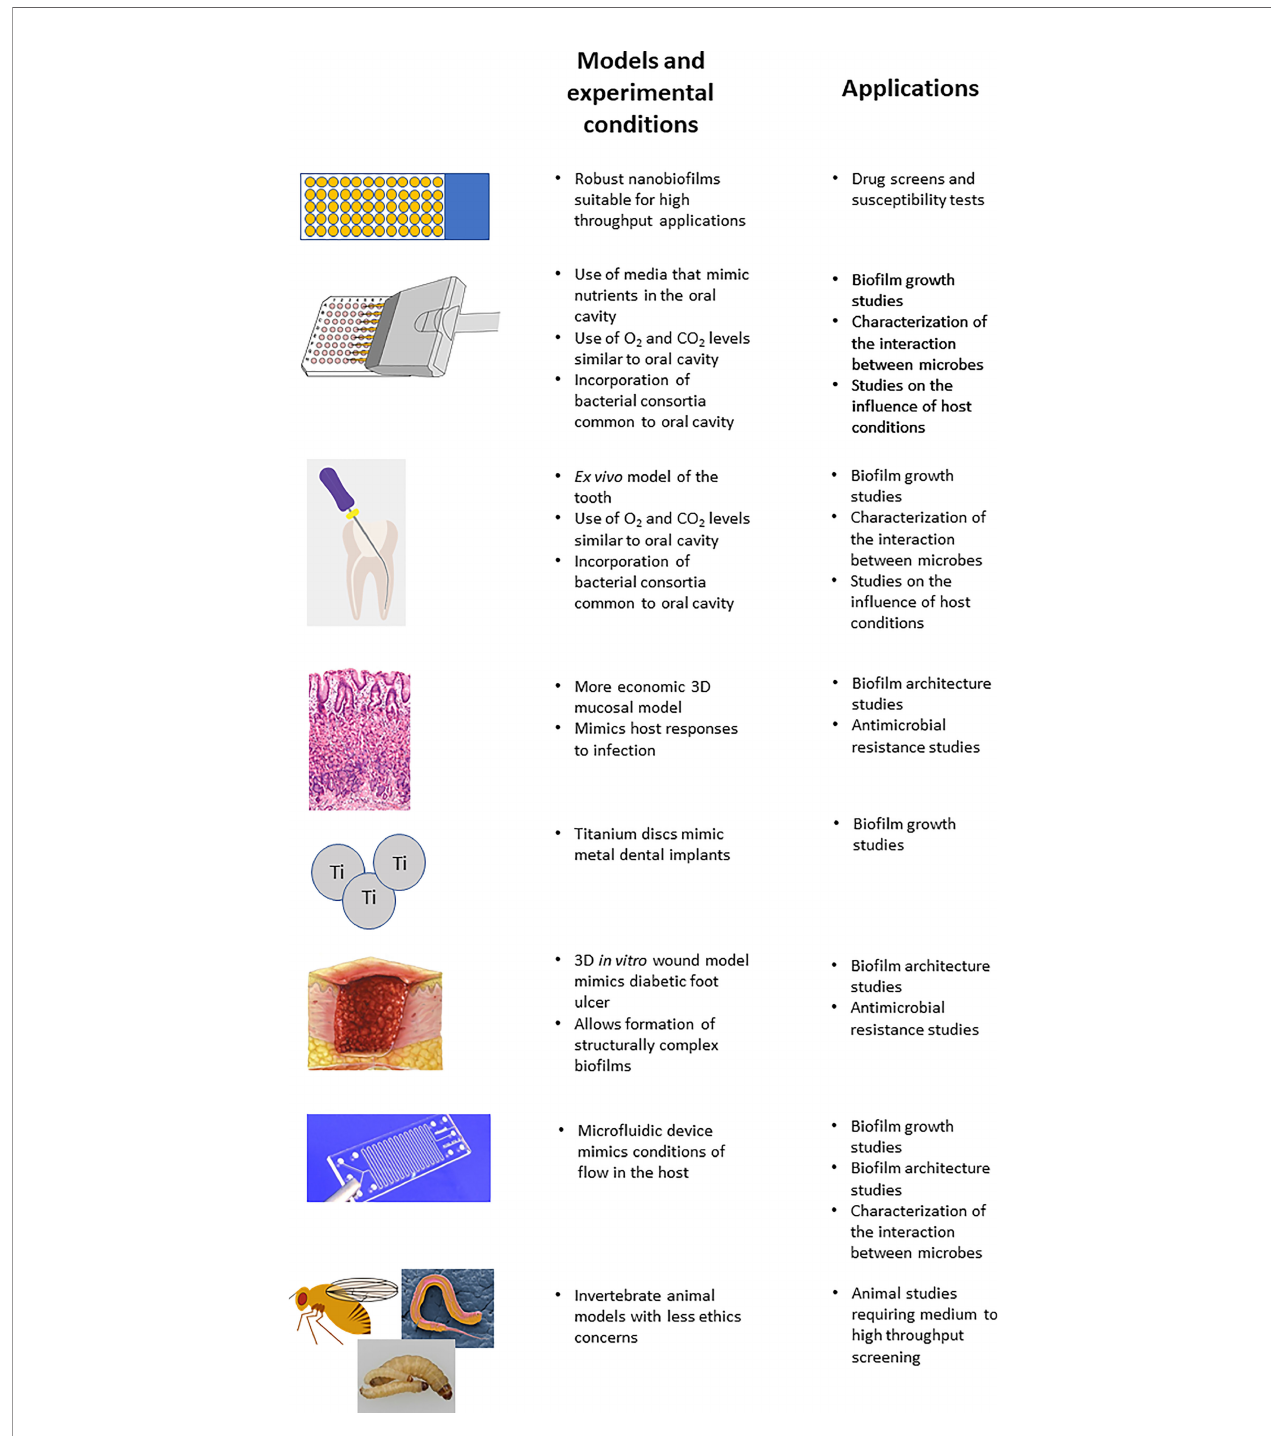
FIGURE 1 | Summary of the models discussed in the study of polymicrobial bio fi